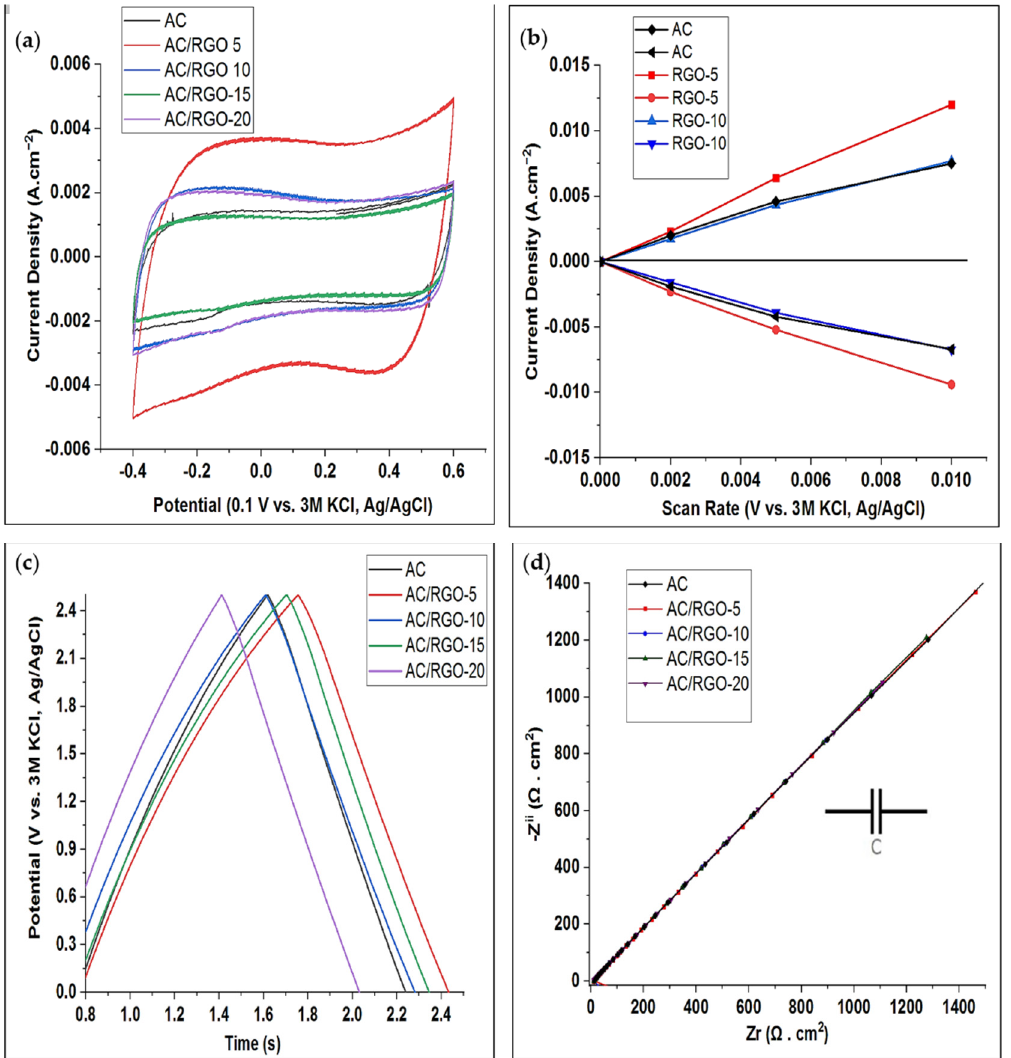
Figure 5. Cyclic voltammogram of ( a ) AC and AC/RGO-x (where x = 5, 10, 15, and 20 wt% RGO) at 2 mV s − 1 s − 1 ( b ) Plots of charging current (above 0 A cm − 2 ) and discharging currents (below A cm − 2 ) against the scan rate (V.s) for C DL determination ( c ) Galvanostat charge-discharge (GCD) of AC and AC/RGO-x at 0.1 A g − 1 and ( d ) Nyquist plot of AC and AC/RGO-x .